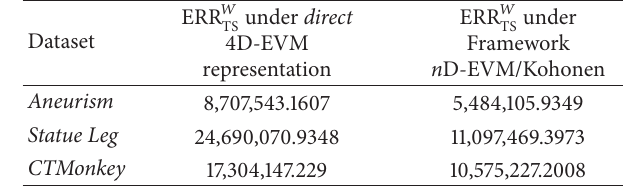
Table 17: CCL 3 s’ comparisons for representation of volume datasets (see text for details).